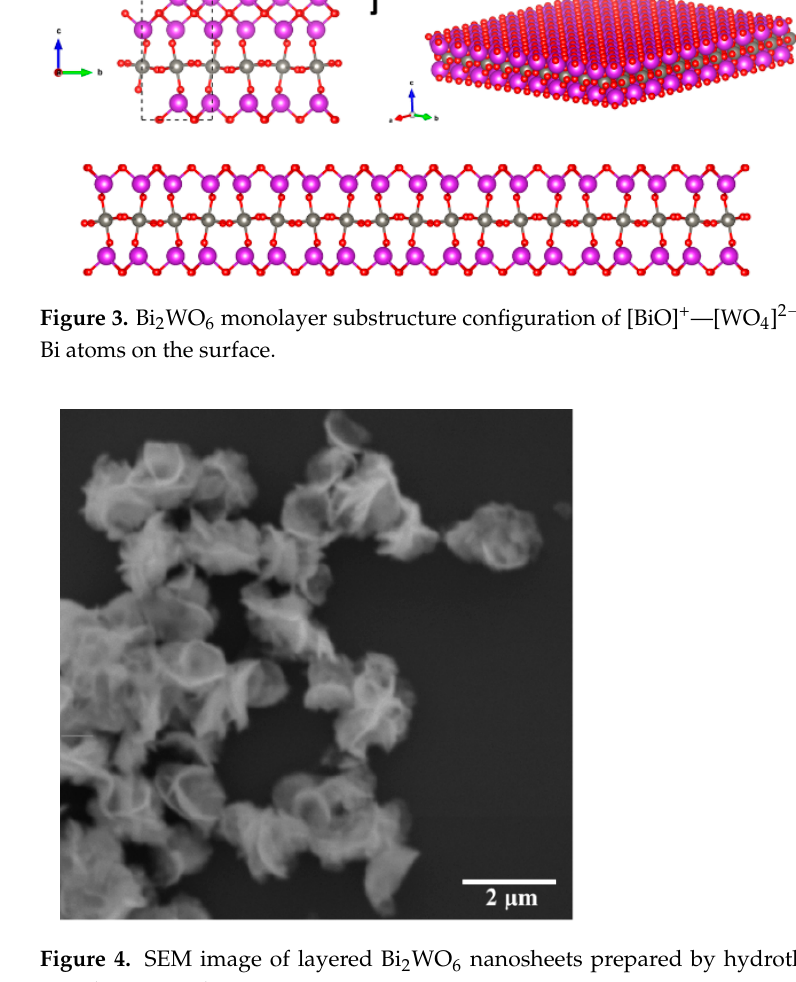
Figure 4. SEM image of layered Bi 2 WO 6 nanosheets prepared by hydrothermal route showing two-dimensional structures.